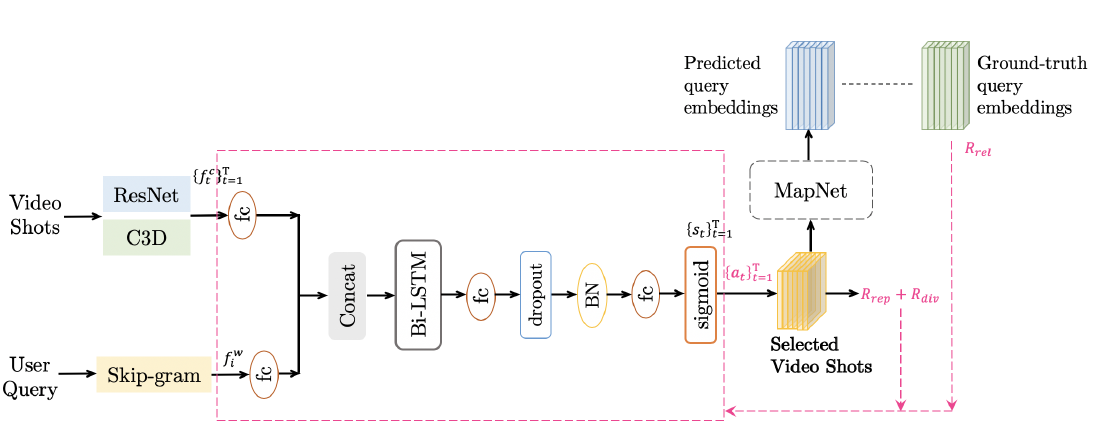
Figure 3. The architecture of our proposed Summarization Network (SummNet). Given a user